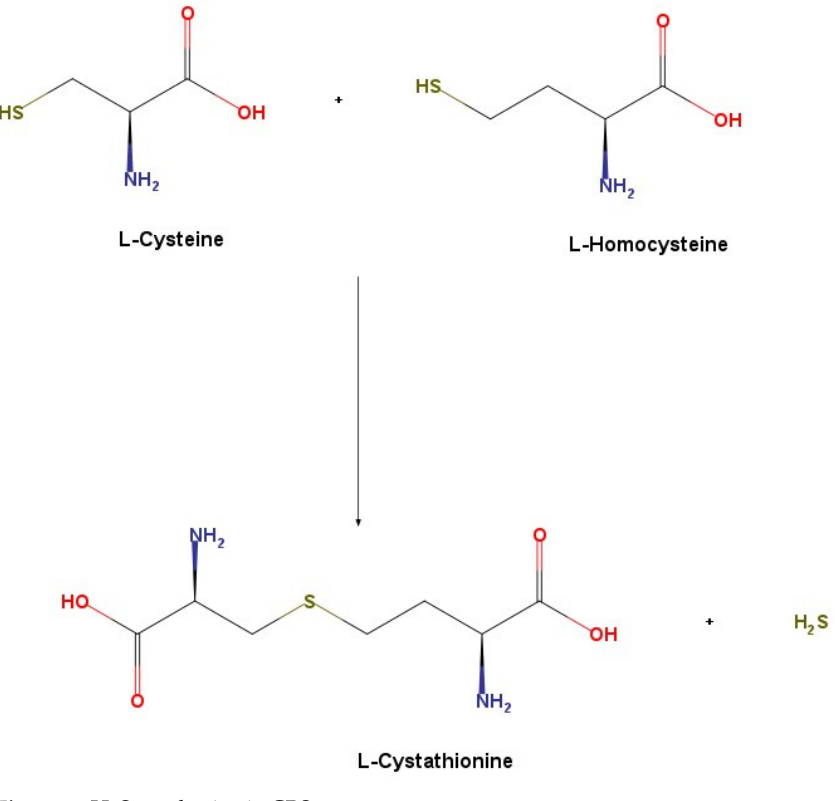
Figure 2. H 2 S synthesis via CBS.